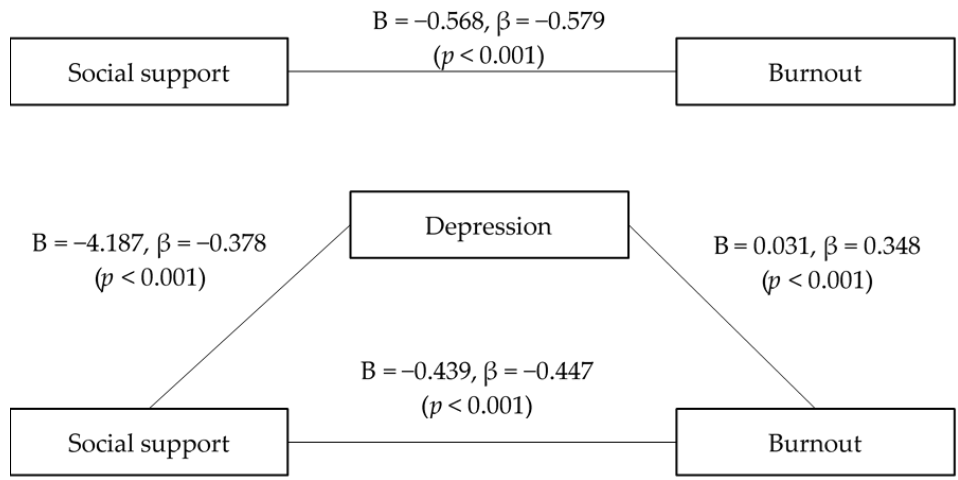
Figure 1. Mediation model of the effects of depression on the relationship between social support and burnout (Sobel’s test: Z = −3.589, p < 0.001) . and burnout (Sobel’s test: Z = − 3.589, p <